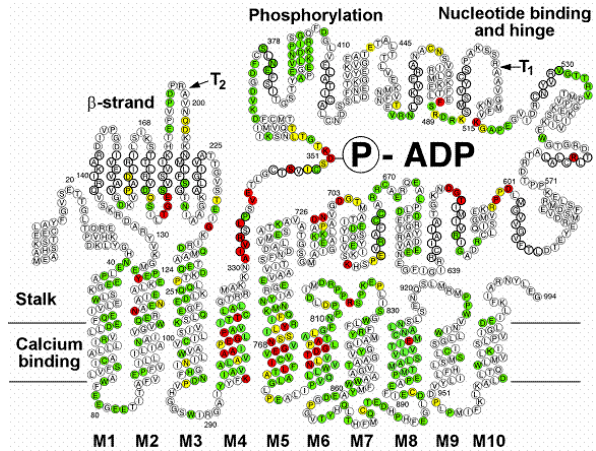
Figure 1. Aminoacid sequence and two dimensional folding model of the SERCA1 Ca 2+ ATPase. 5 See text for explanations.